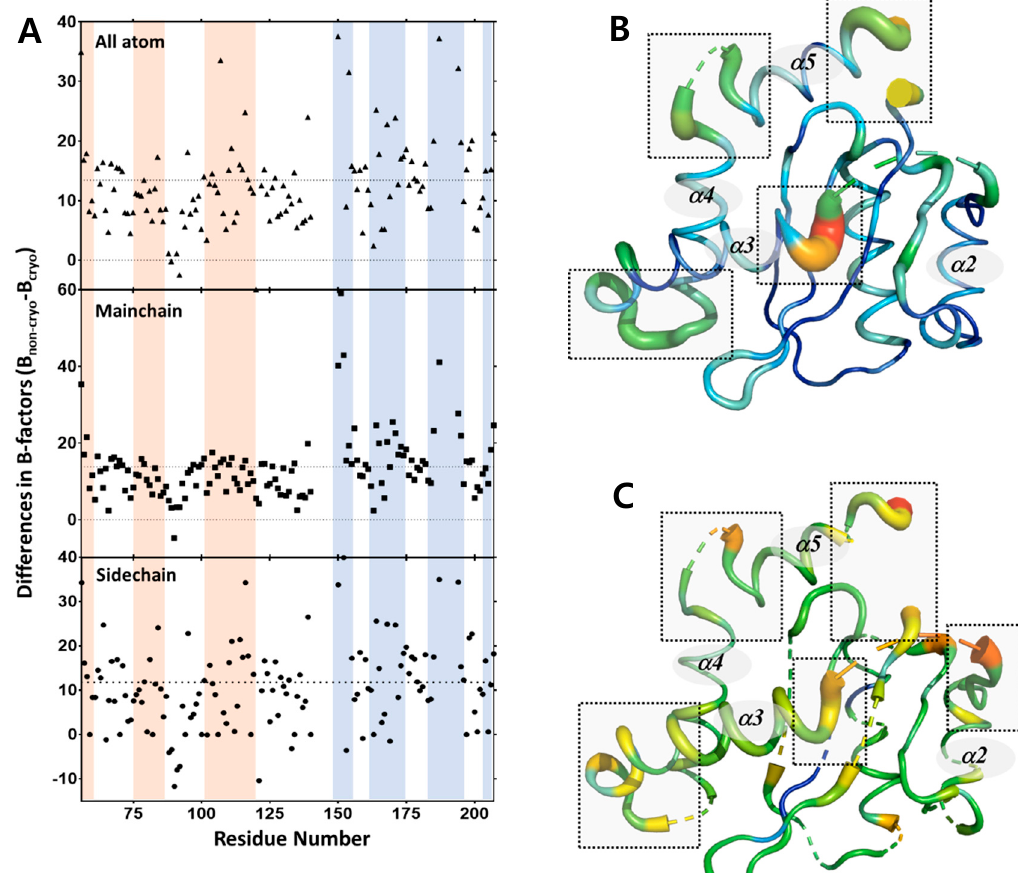
Figure 5. Differences in B-factors between non-cryogenic and cryogenic structures together with NMR data. ( A ) Difference in the B-factors (B non-cryo -B cryo ) for all atoms, main chain atoms, and side chain atoms are plotted versus residue number. ( B ) Putty representation of the HIV-1 integrase catalytic core domain shows the differences in B-factors (B non-cryo -B cryo ) of main chain atoms. ( C ) Putty representation of the HIV-1 integrase catalytic core domain shows the average values of the NMR dynamics results (R 1 , R 2 , 15 N -{ 1 H} NOE). Note that a greater width and the color red indicates a higher value, while a narrower width and the color blue denotes a lower value.